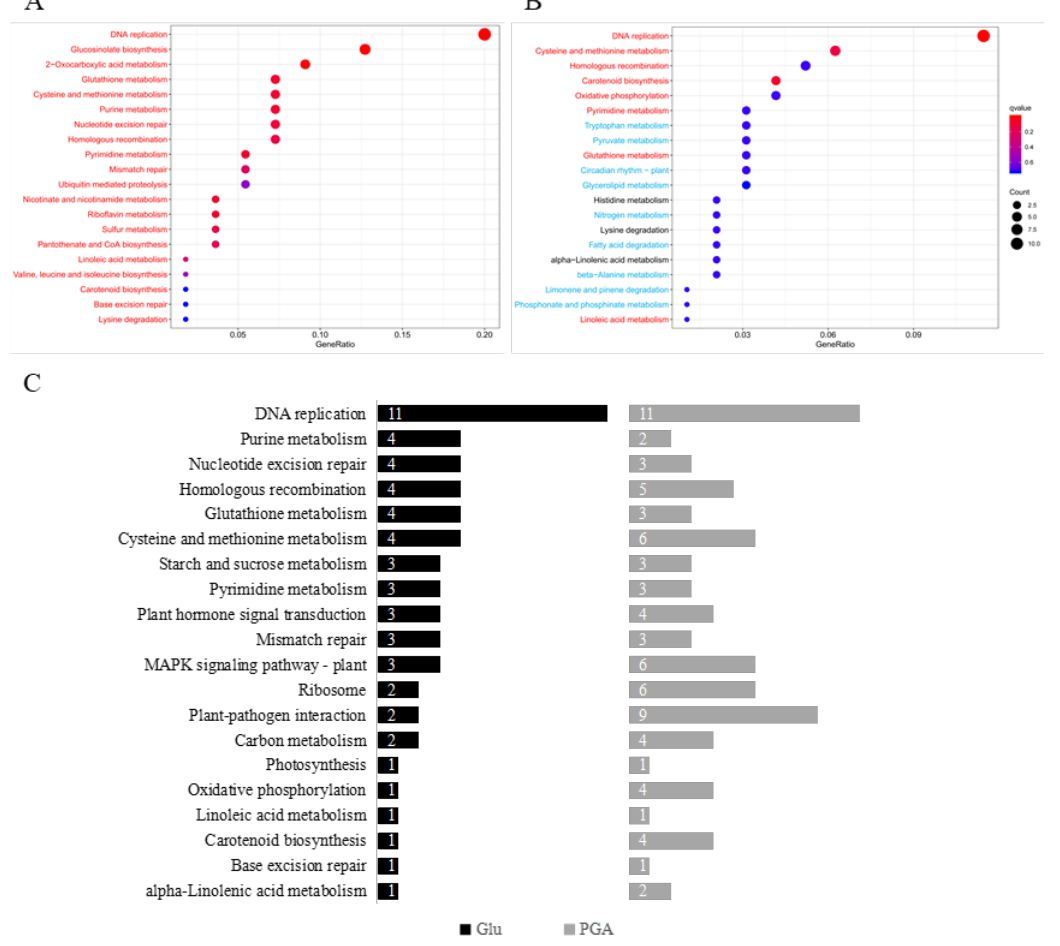
Figure 5. KEGG classifications of DEGs in different groups. The vertical axis represents the pathway name, and the horizontal axis represents the gene number ratio of significant DEGs to the total genes in a given KEGG pathway. The size of the dots indicated by “Count” represents the number of DEGs in the pathway, and the color of the dots corresponds to the different q-value ranges. ( A ) Glu relative to Ctrl.; ( B ) γ -PGA relative to Ctrl.; ( C ) Glu and γ -PGA commonly expressed relative to Ctrl. Each figure showed top 20 pathways with q-values. Red and blue letters indicate more than 50% up- regulated and down-regulated DEGs out of a total number of DEGs, respectively. Black letter indi- cates each 50% of up- and down-regulated DEGs.